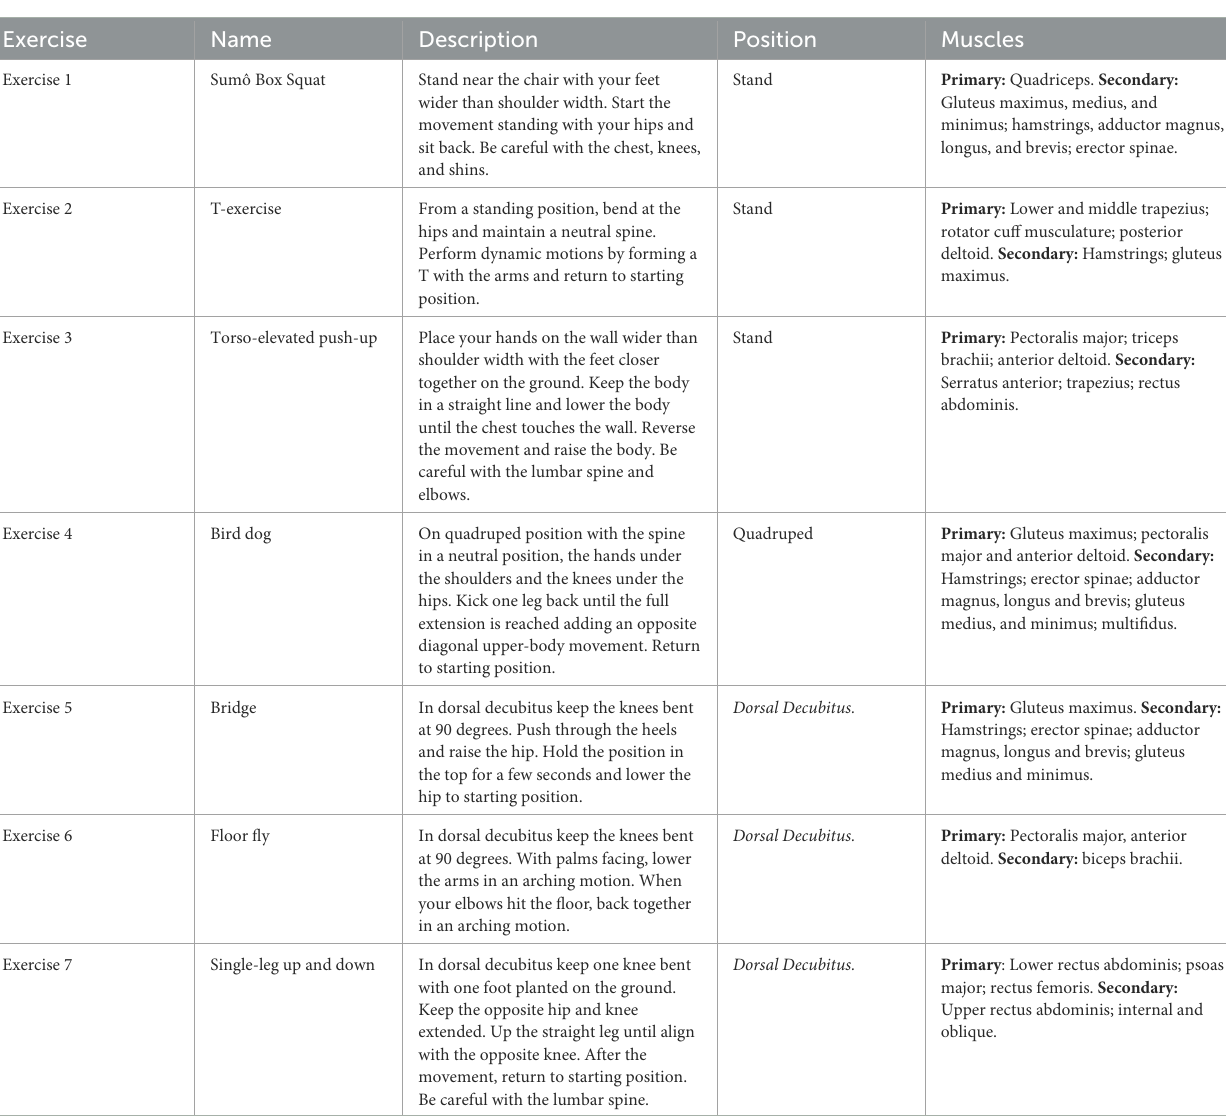
TABLE 2 Description of strength